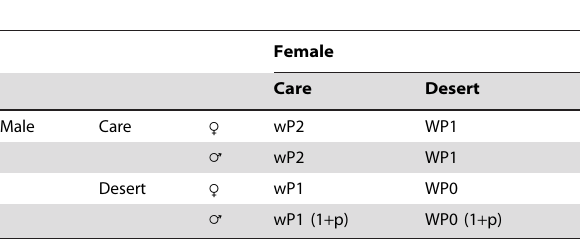
Table 2. Payoff matrix and four evolutionary stable strategies (ESS) from the game theory model